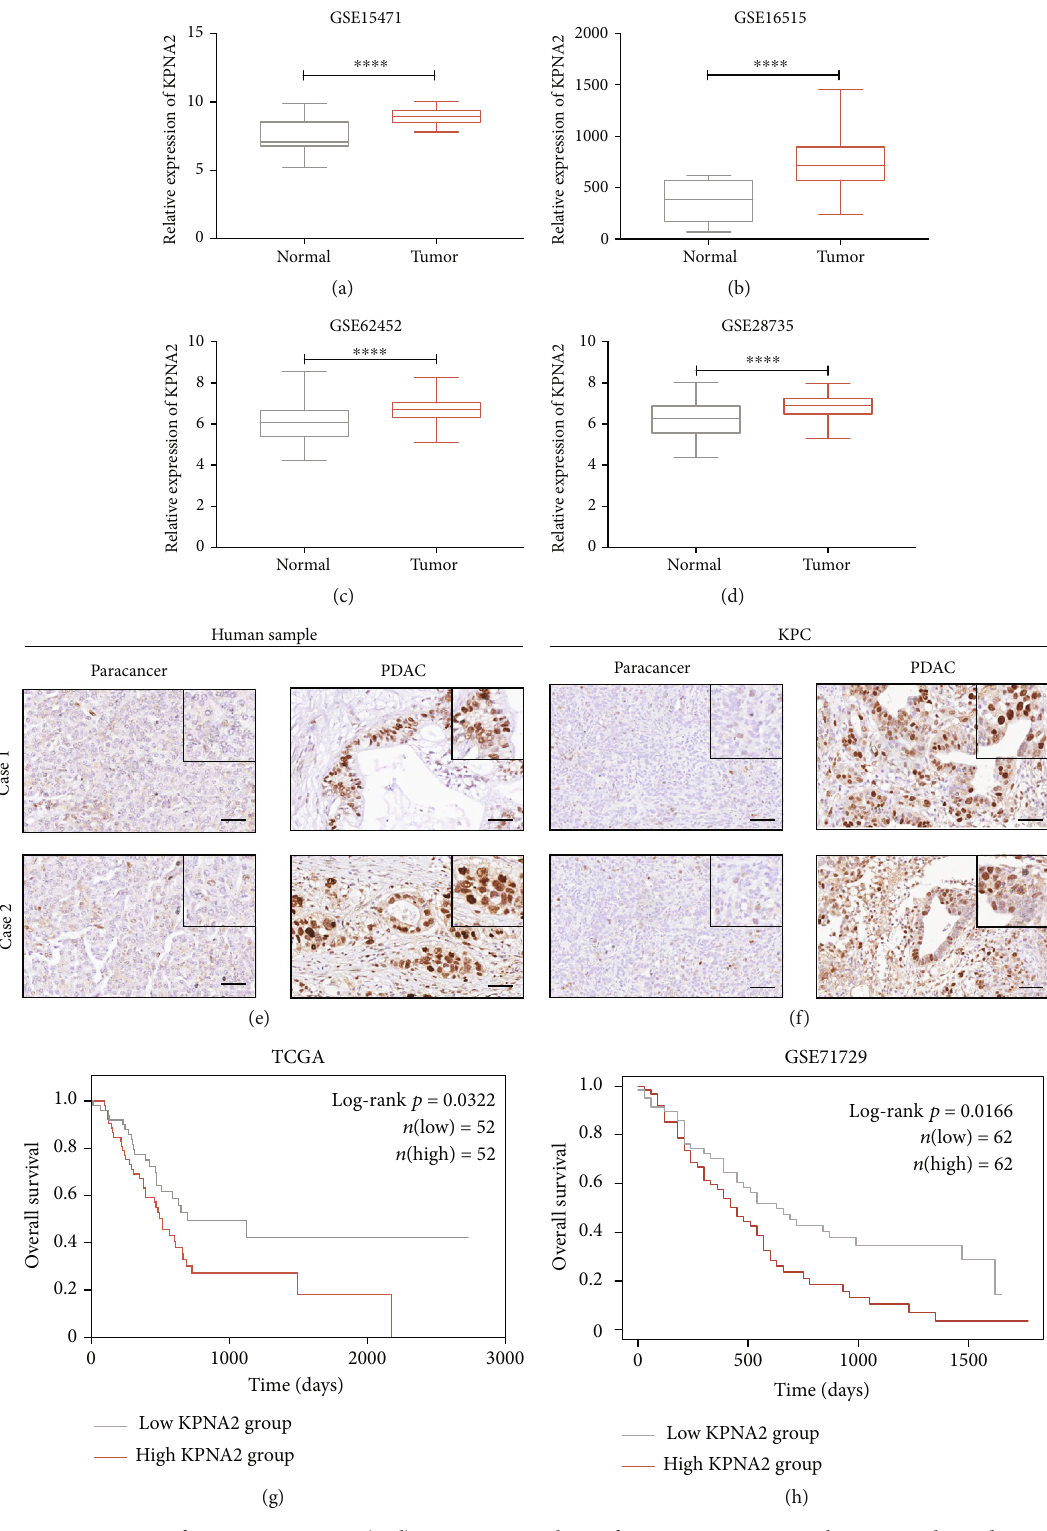
Figure 1: Expression pattern of KPNA2 in PDAC. (a – d) Expression analysis of KPNA2 in tumors and corresponding adjacent nontumor tissues using four independent GEO datasets (GSE15471, GSE16515, GSE62452, and GSE28735) (Student ’ s t -test, ∗∗∗∗ P < 0 : 0001 ). (e) IHC staining of KPNA2 expression in PDAC tumor (scale bar: 100 μ m). (f) IHC staining of KPNA2 expression in the engineered mouse model of KPC (scale bar: 100 μ m). (g) Kaplan-Meier overall survival (OS) curves in the TCGA dataset of PDAC patients according to the mRNA expression of KPNA2, the lower quartile value of expression was utilized as a cut-o ff (log-rank test, P = 0 : 0322 ). (h) Kaplan-Meier OS curve for the MPC1 expression in the GSE71729 dataset (log-rank test, P = 0 : 0166